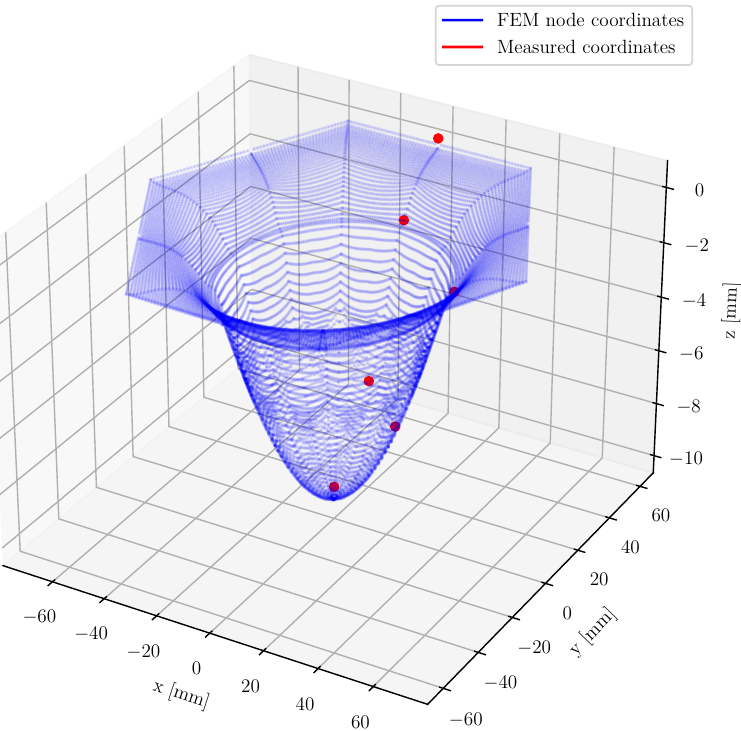
Figure 3. Comparison of the computed node displacement and the measured displacement at selected points of the concept with respect to Tamer et al.